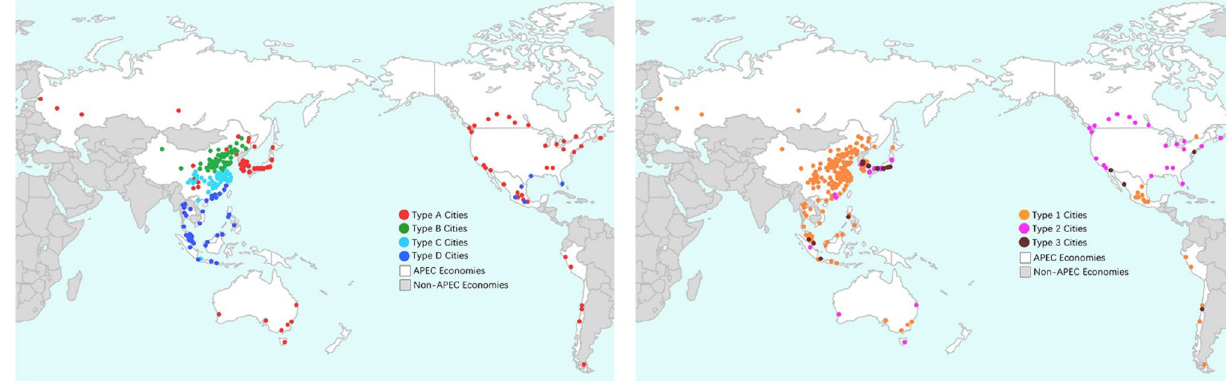
Fig. 3 Spatial pattern of cities identified by two types of indicators